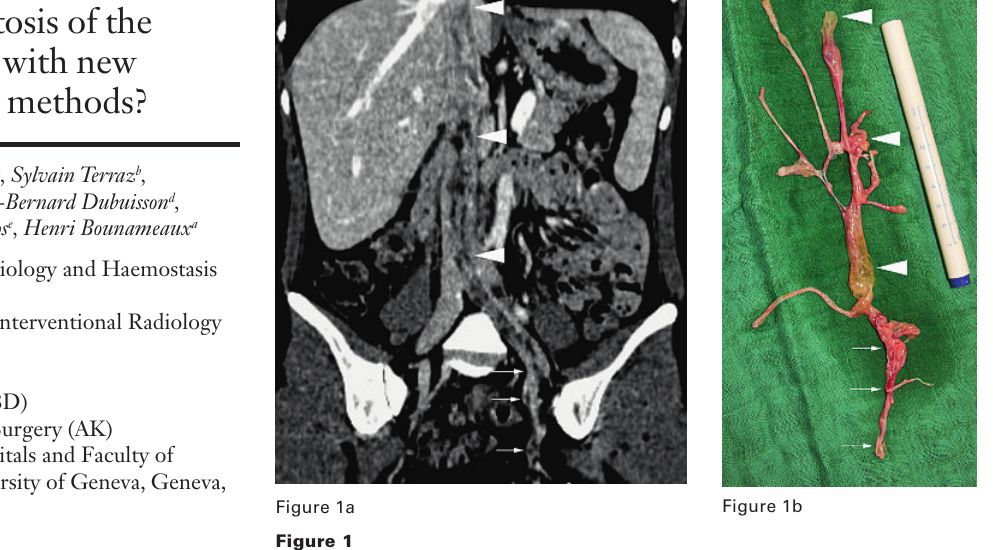
Contrast-enhanced CT of the abdomen with curved coronal reconstruction (fig. 1a) and surgical specimen (fig. 1b) showing a complex mass in the lumen of the left internal iliac vein (small arrows) extending to the inferior vena